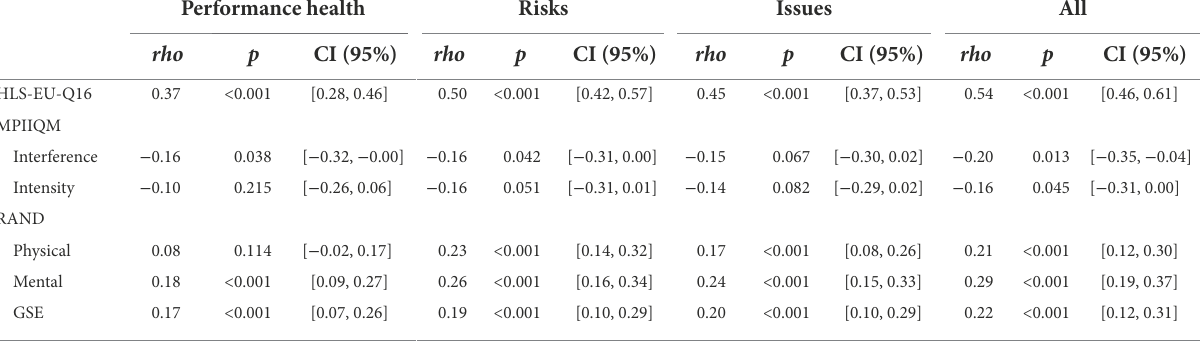
TABLE 5 Hypothesis